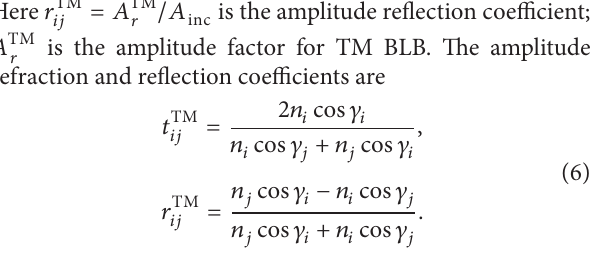
Here 𝑟 TM 𝑖𝑗 = 𝐴 TM 𝑟 /𝐴 𝐴 TM